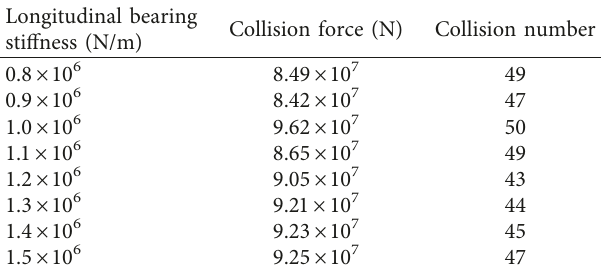
Table 3: Collision force and number of collisions.